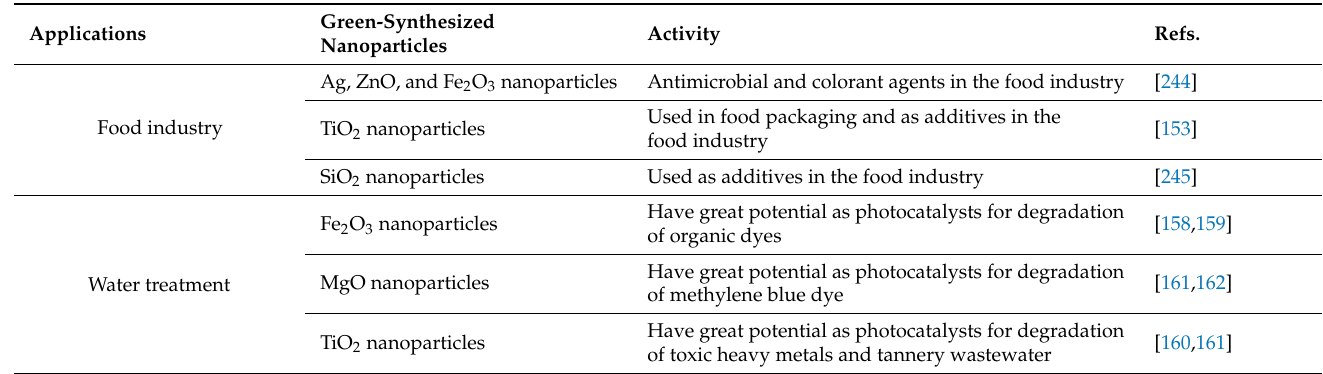
Table 4. Different applications of green synthesized